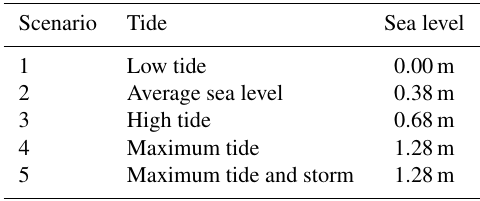
Table 8. Sea level for each evaluated